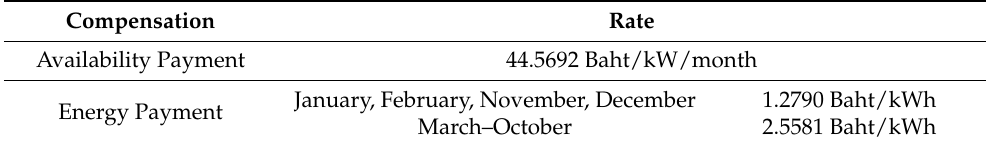
Table 1. Demand response rates implemented in the current demand response